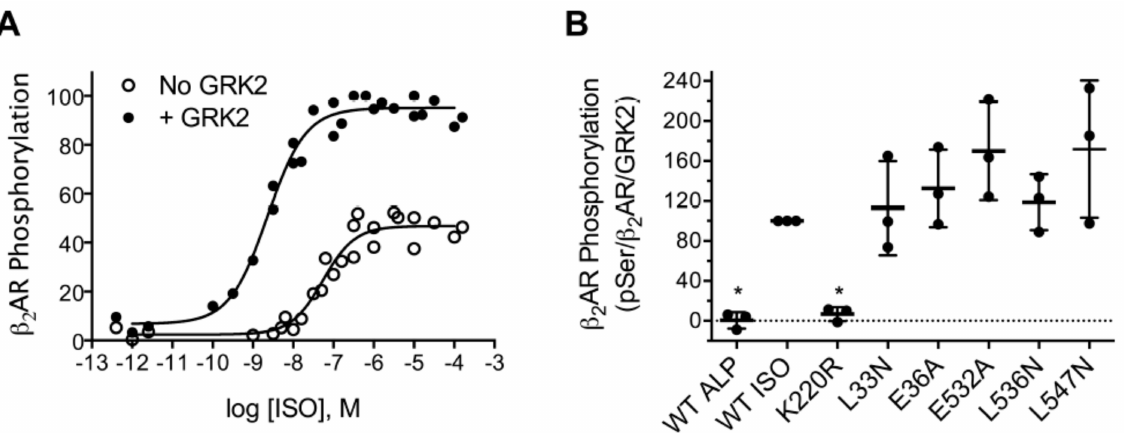
Figure 6. Intact cell phosphorylation of WT β 2 AR. COS-7 cells were transfected with FLAG-tagged WT β 2 AR, G α s , G β , G γ , and GRK2 ( A ) or GRK2-H 6 and its RH domain mutant variants ( B ), where indicated. Cells were stimulated with 2-nM isoproterenol (ISO), and lysates were subjected to immunoblotting. Phosphorylated β 2 AR was detected with a pSer555/pSer556 phosphorylation site antibody (pSer), total β 2 AR was detected with an antibody that recognizes the carboxyl tail of the receptor ( β 2AR), and GRK2 was detected with a polyclonal antibody. ( A ) Phosphorylated β 2 AR as a function of the ISO concentration (dose response). Shown are all the data points from three independent experiments. ( B ) Phosphorylation by GRK2 variants. The level of phosphorylation was normalized to the levels of both the total receptor and GRK2 and expressed as a percentage of the WT. Data from three independent experiments are shown. No statistically significant differences between WT and RH domain mutants were observed. * p < 0.05. Error bars show the mean and